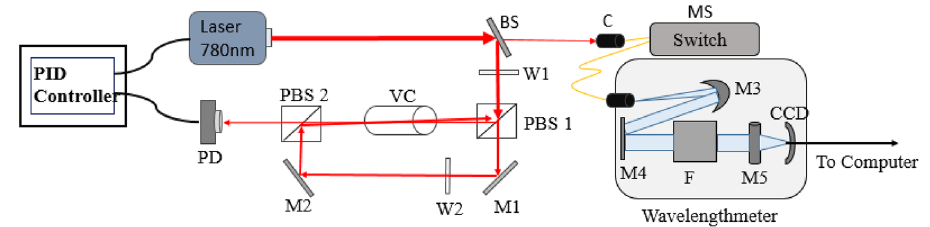
Figure 1. Schematic representation of the experimental setup for laser locking using saturated absorption spectroscopy (SAS). Here, BS—90:10 beam splitter, W1, and W2—quarter-wave plates, PBS1 and PBS2— polarizing beam splitters, VC—Rb vapour cell, M1, M2, M3 and M4—mirrors, M5—cylindrical mirror, PD— photodiode, MS—multichannel switch, C—fibre coupler, F—Fizeau interferometer, CCD—charged coupled